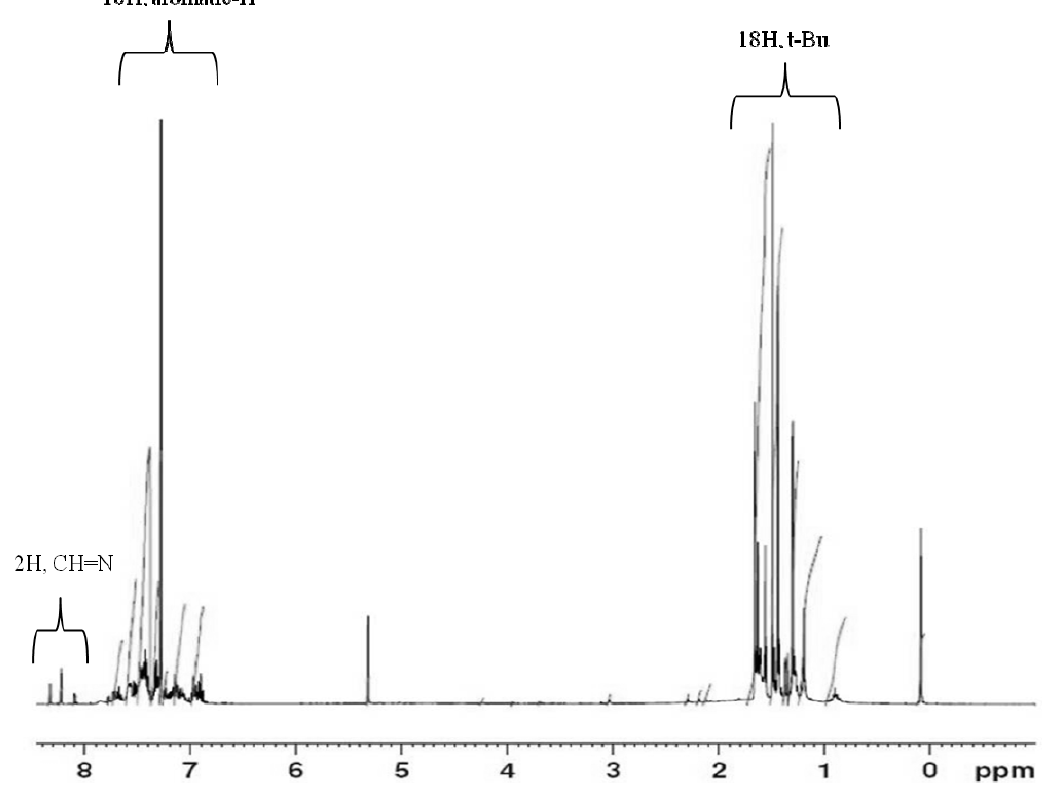
Figure 2. 1 H-NMR of Ti-FI complexes having phenoxyimine ligands.